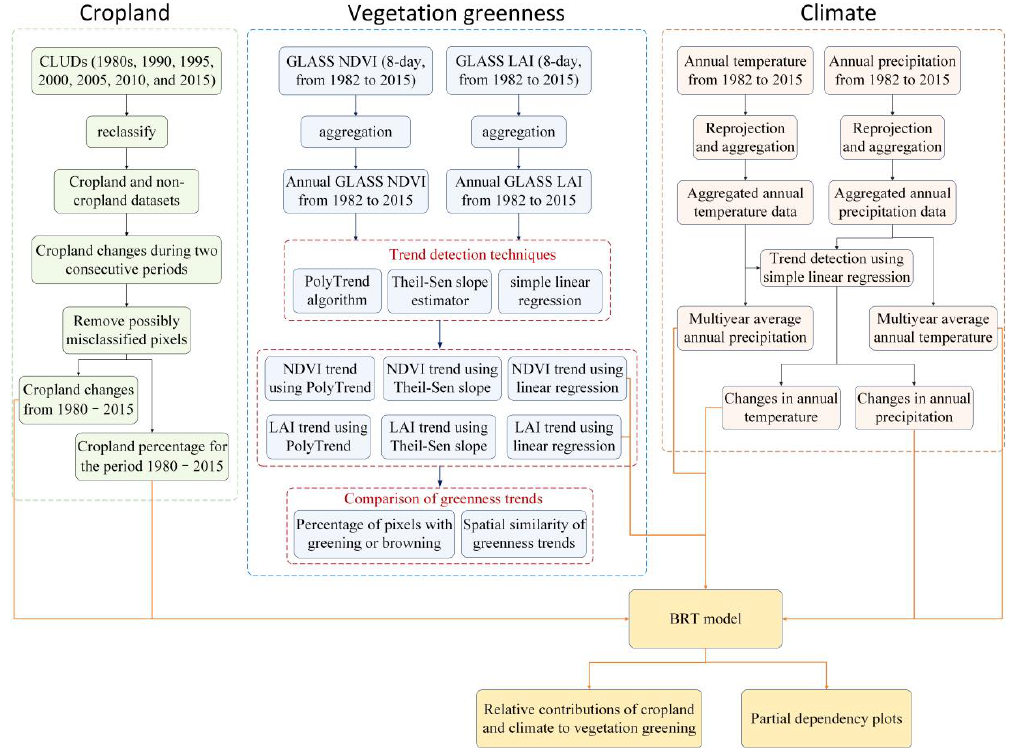
Figure 1. Flowchart showing the datasets, pre-processing, and statistical analysis methods used to explore the relative impacts of cropland and climate on changes in vegetation greenness.